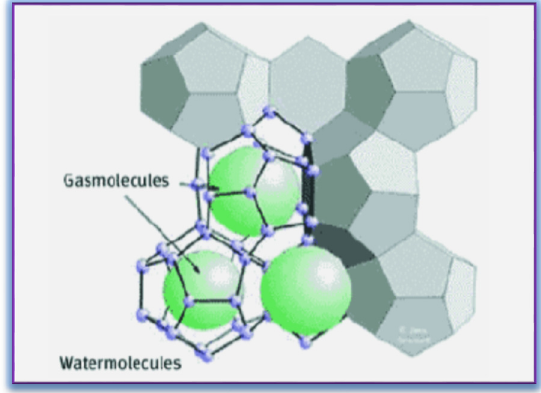
Fig. 1. Structure of gas clathrate hydrate